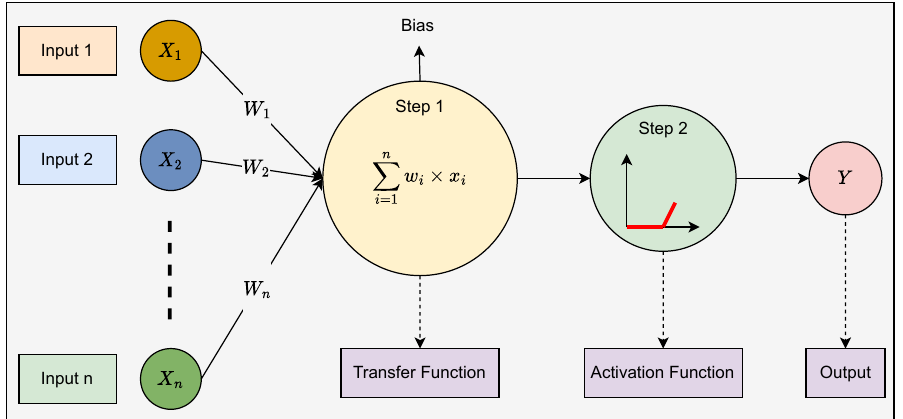
Figure 5. Structure of